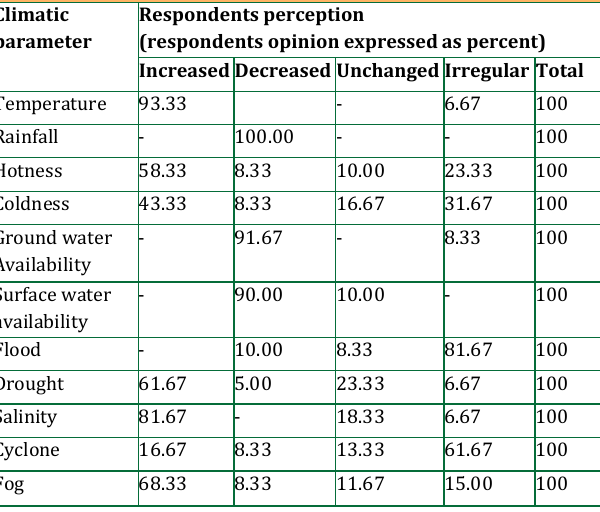
Table 1: Farmer’s perception on changes in climatic variables and